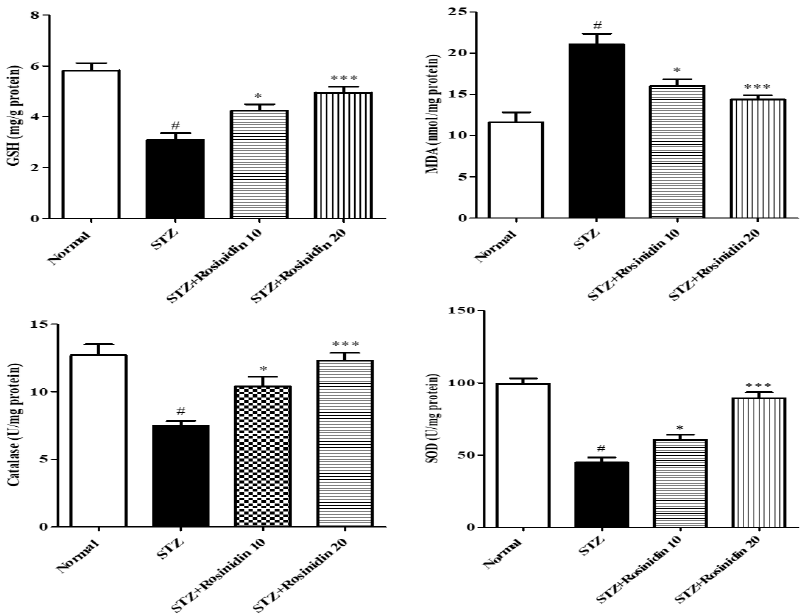
Figure 5. The effect of rosinidin on antioxidant enzyme activities. All the values are presented as the mean ± SEM. Correlation among the groups was done using Tukey’s test by one-way ANOVA. p -value < 0.001, 0.05 were expressed as ***, * respectively as compared with the streptozotocin (STZ) group. # significant as compared with the controls ( p < 0.001).